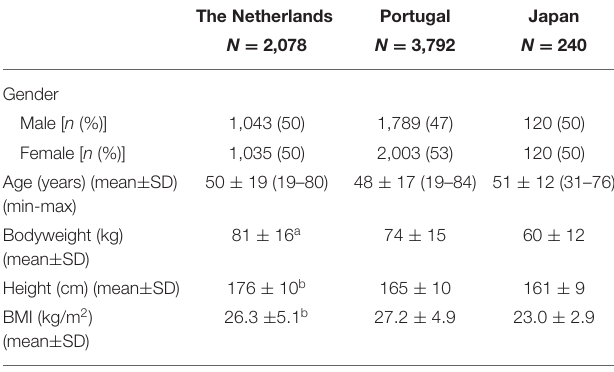
TABLE 3 | Characteristics of Dutch, Portuguese and Japanese